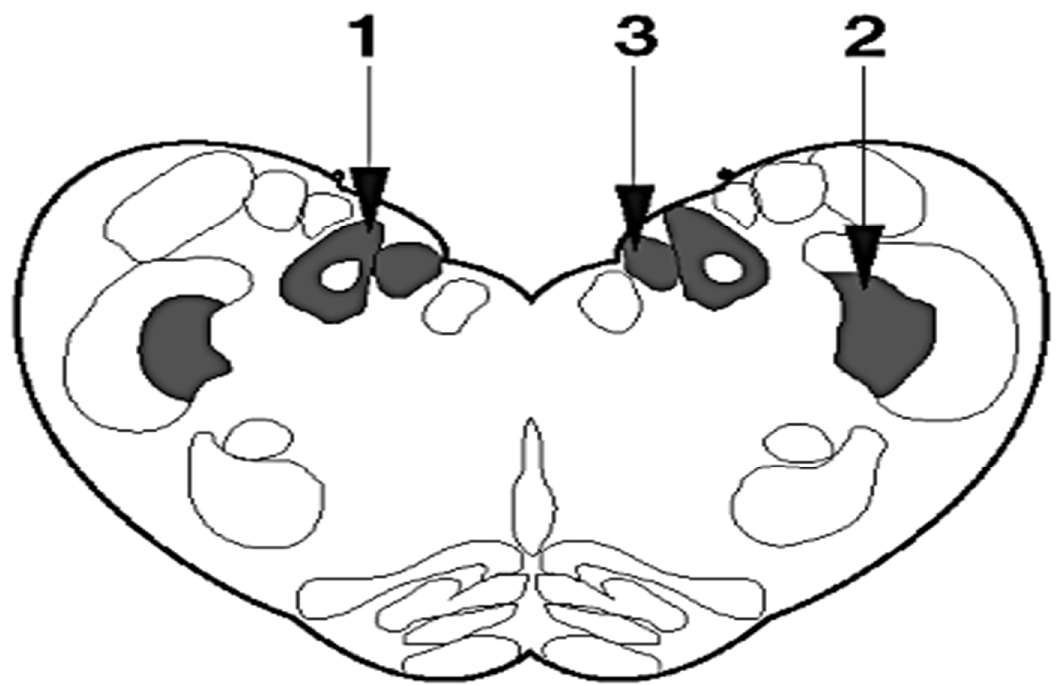
Figure 2. Cross-section of the bovine obex identifying the target sites for BSE diagnosis: (1) nucleus of the solitary tract; (2) nucleus of the trigeminal nerve; (3) dorsal motor nucleus of the vagus nerve. Reprinted from Ref. [17].